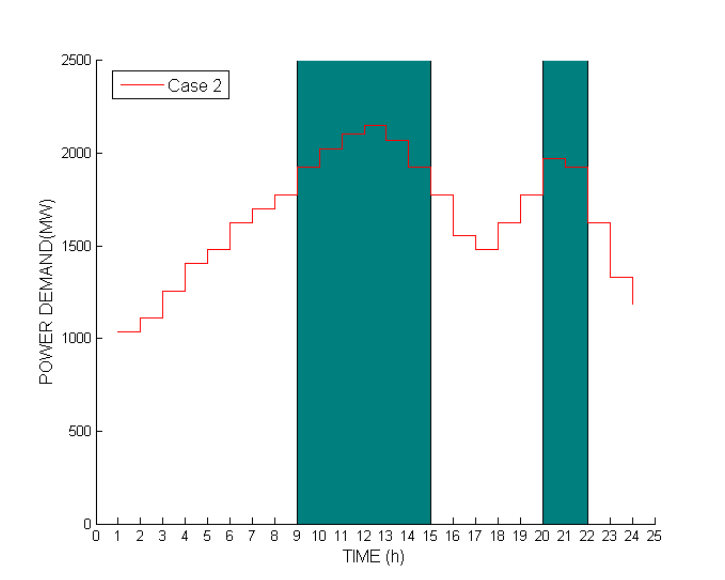
Figure 1. Initial power demand for Case 1.